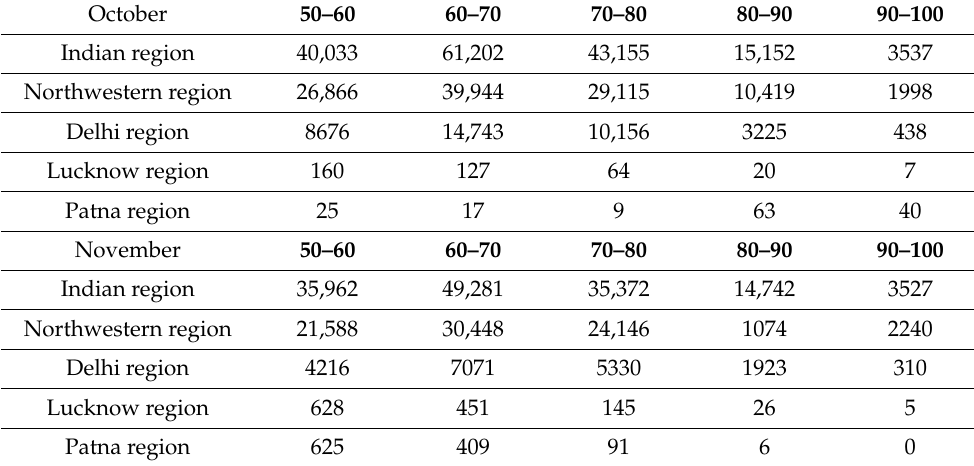
Table 1. Total number of fire counts averaged over selected regions of IGP for significant ranges